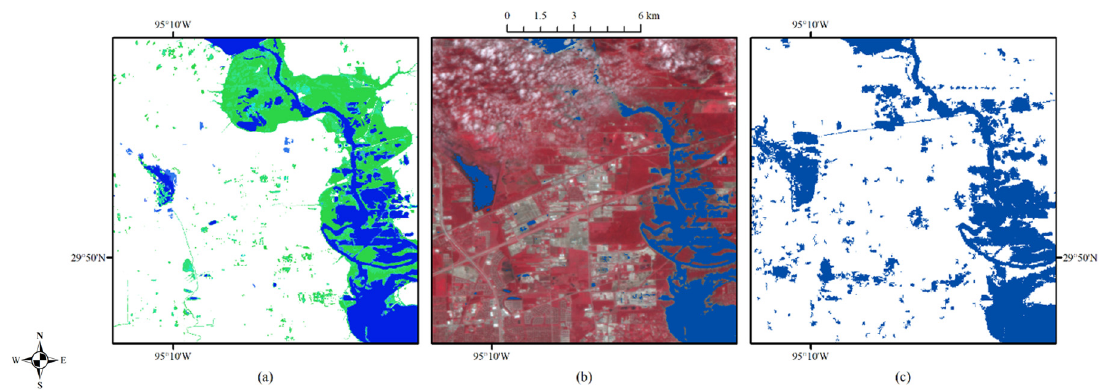
Figure 16. Enlarged site (F): inundation probability ( a ), the corresponding optical image on 1 September ( b ), and ( c ) FEMA flood map, with water shown in blue.